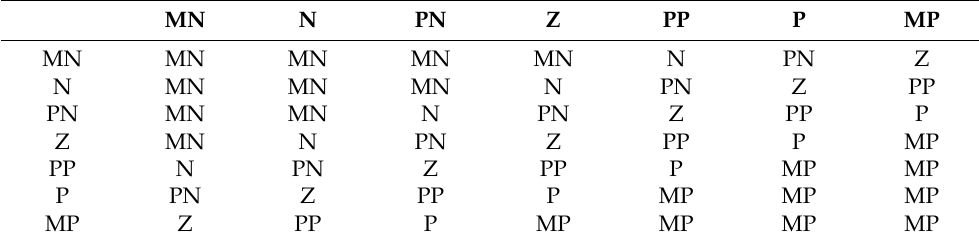
Figure 8. ( a ) Level of membership function; ( b ) filter output as shown in surface view. Table 2. FIS rule